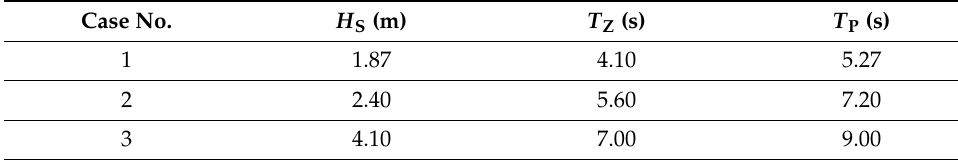
Table 8. Wind and Current Parameters.